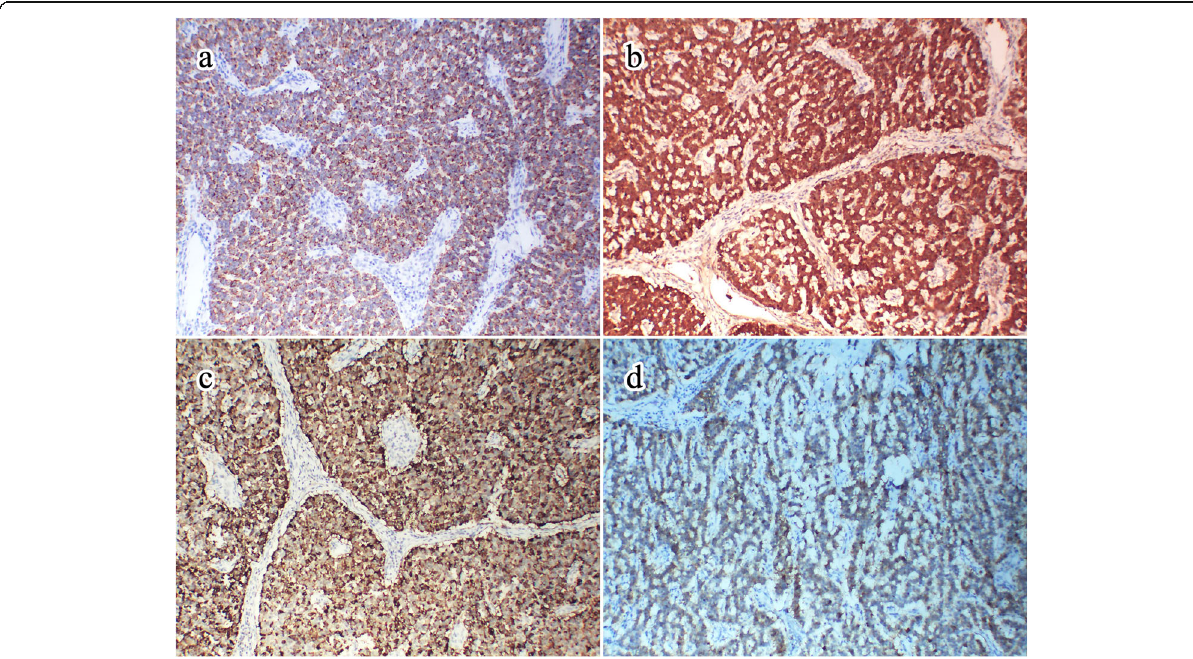
Fig. 3 The image of immunohistochemistry. a represented the tumor cells were dot-like positive for CK (100×). b , c showed diffusely cytoplasmic positive for NSE, CGA respectively in tumor cells (100×). d Tumor cells showed patchy cytoplasmic positive for CD56